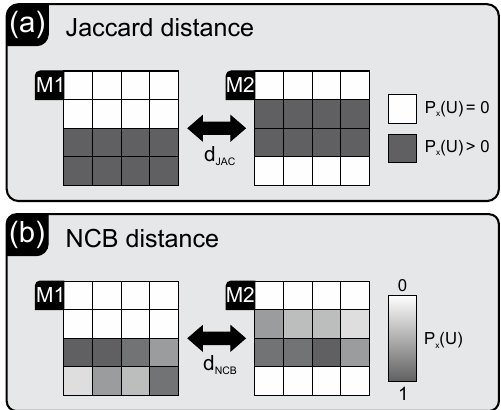
Figure 5. Distance measures used to calculate dissimilarities be- tween models ( M 1, M 2). (a) Jaccard distance ( d JAC ) using a true/false binary function and (b) normalized city-block distance based on a probability